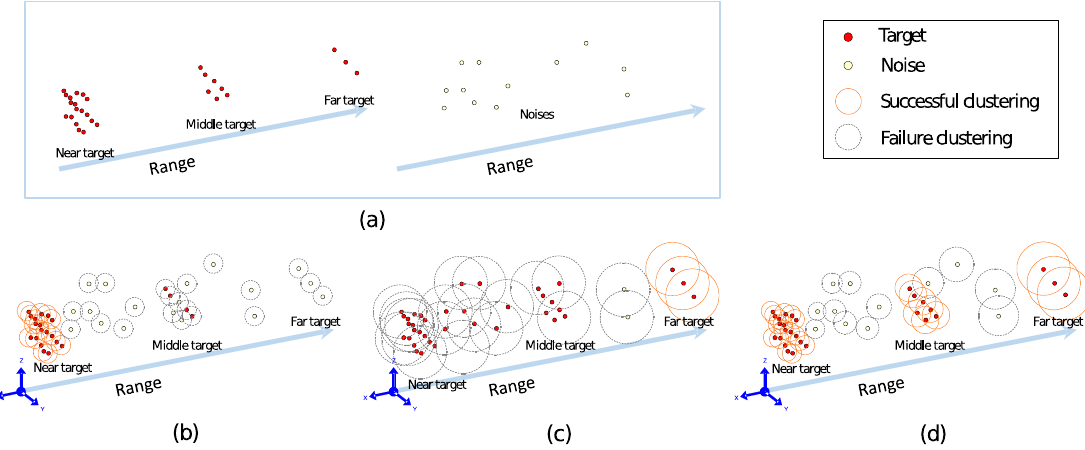
Figure 9. Basic concept of variable radial basis nearest neighbor clustering method. ( a ) Ground truth, ( b ) RBNN (R = 0.06 m), ( c ) RBNN (R = 0.2 m), ( d )